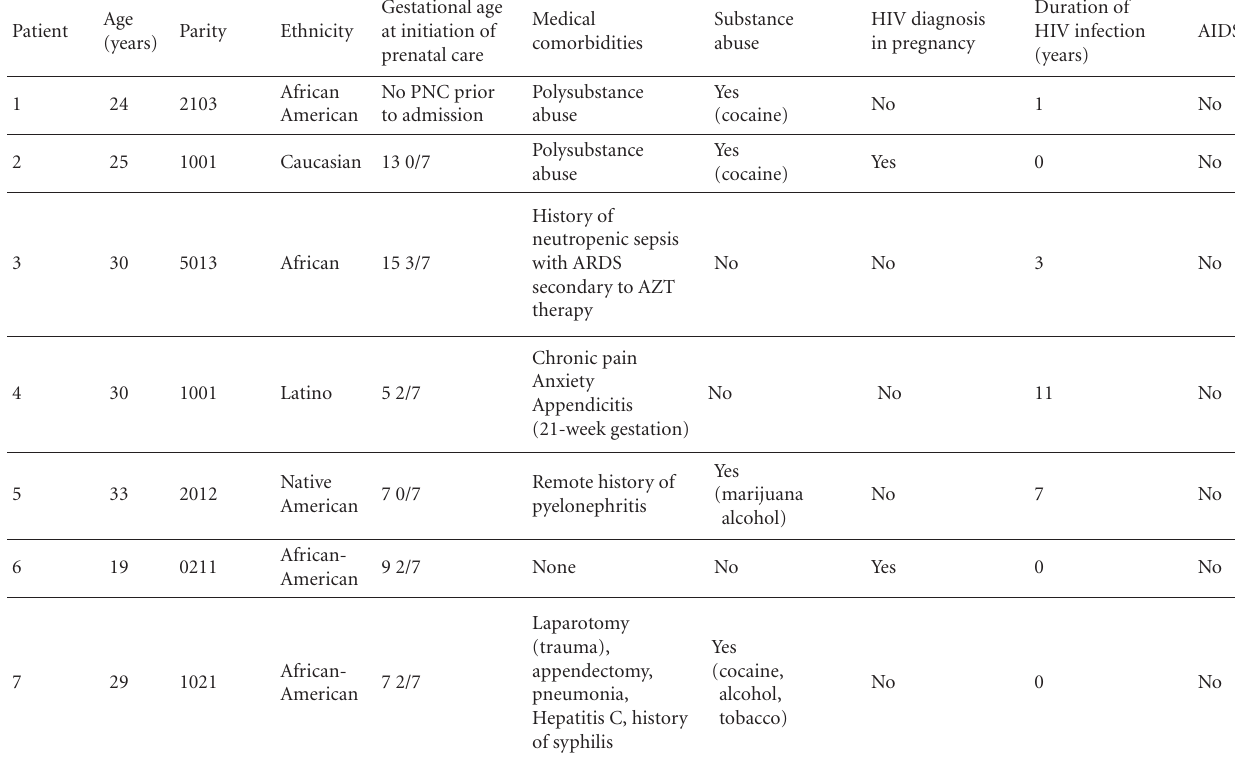
Table 1: Patient characteristics on admission. PNC: prenatal care; ARDS: adult respiratory distress syndrome; AZT: zidovudine; AIDS: acquired immunodeficiency syndrome; N/A: data not